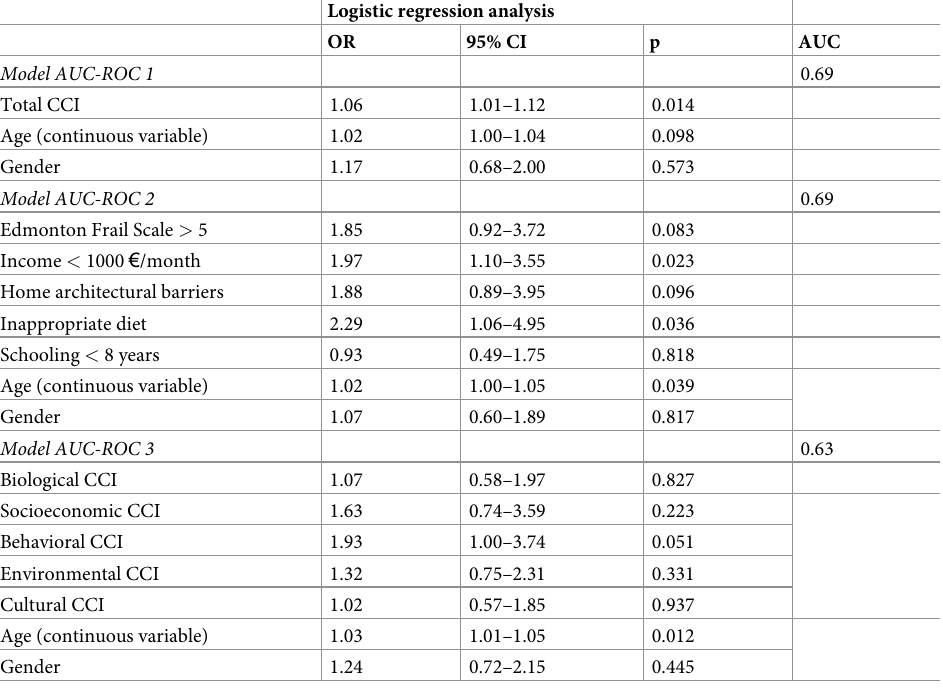
Table 2. Independent correlates of being a holiday case, including total clinical complexity index ( Model AUC-ROC 1 ), single clinical complexity index variables ( Model AUC-ROC 2 ), and clinical complexity index domains ( Model AUC-ROC 3 ).